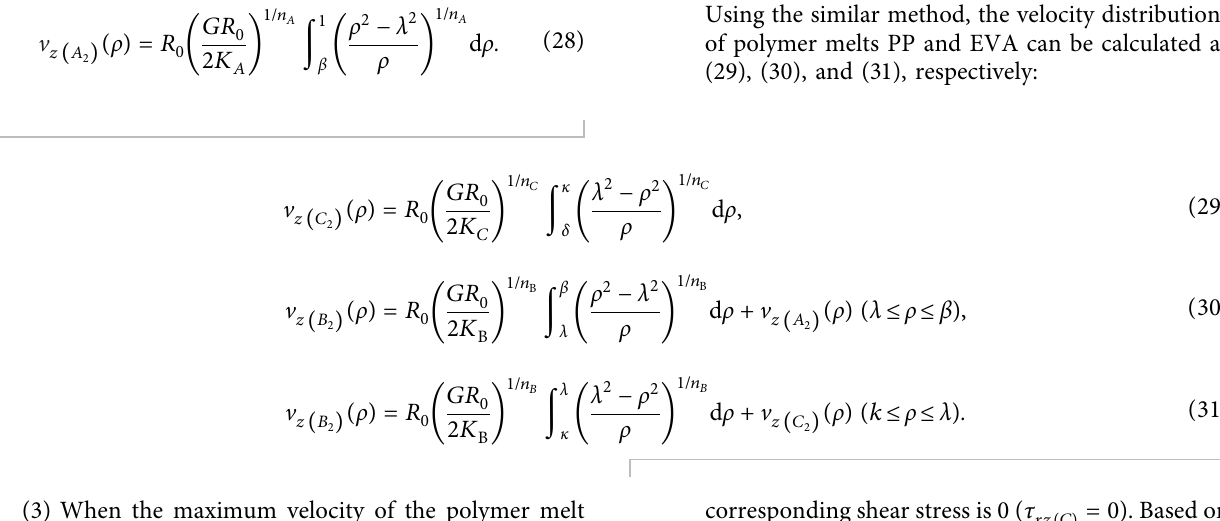
Figure 7: Graphics of cross sections of catheters at different air injection volume rates. (a) Q min, (d) Q 4 � 10 mL/min, (e) Q 5 � 12mL/min, (f) Q 6 � 14mL/min, (g) Q 7 � 16mL/min, (h) Q 8 � 18mL/min, (i) Q 9 � 20mL/min, (j) Q 10 � 22mL/min, (k) Q 11 � 24mL/min, (l) Q 12 � 26mL/min, and (m) Q 13 �